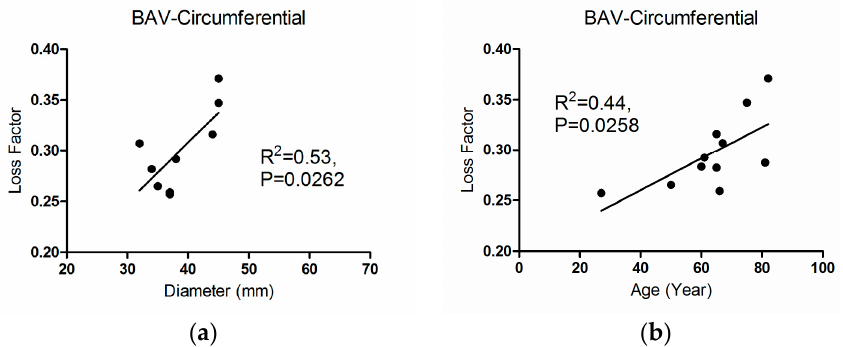
Figure A3. Average circumferential loss factor of the BAV group with respect to ( a ) diameter; and ( b ) age.